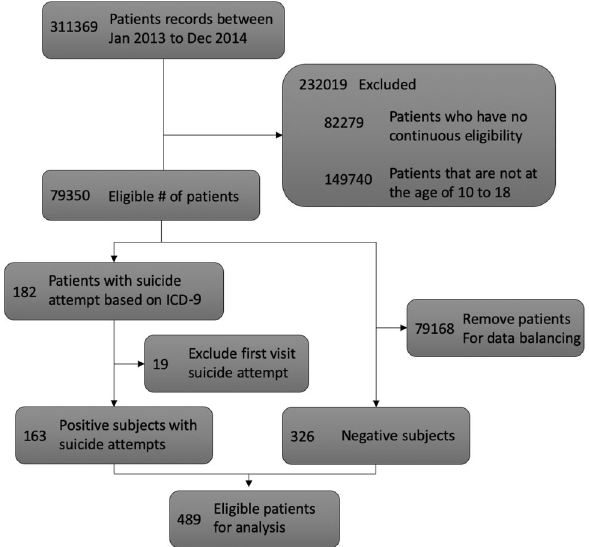
Figure 5. The cohort selection process for the study of suicide risk prediction.